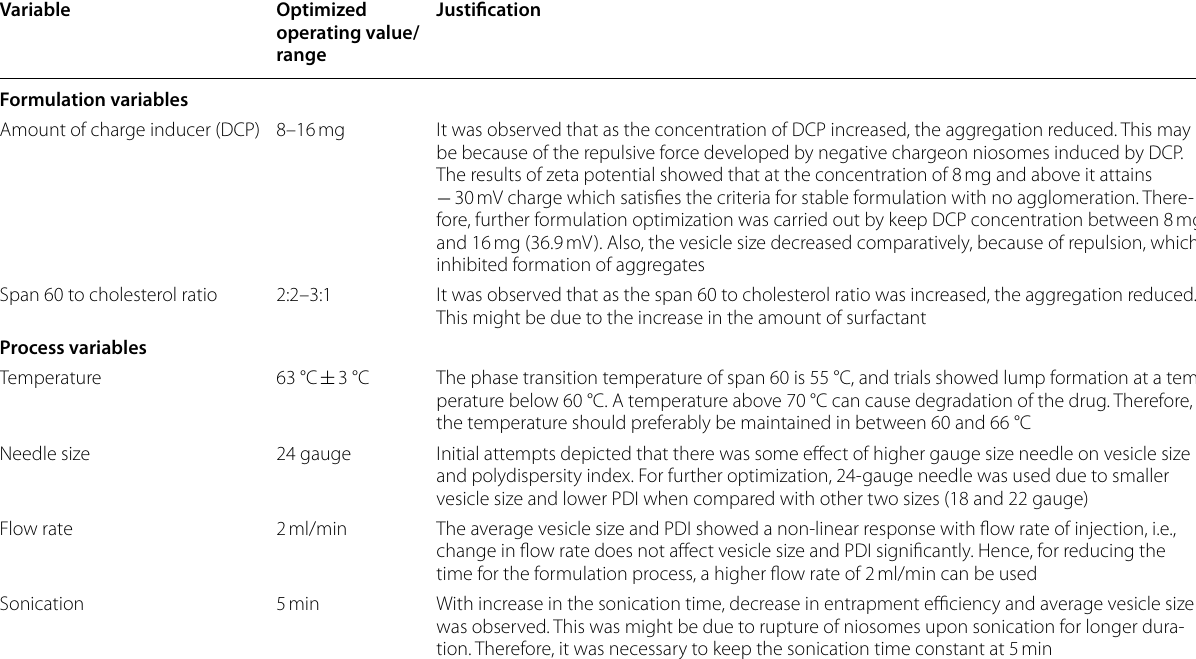
Table 3 Range of optimized variables Variable Optimized